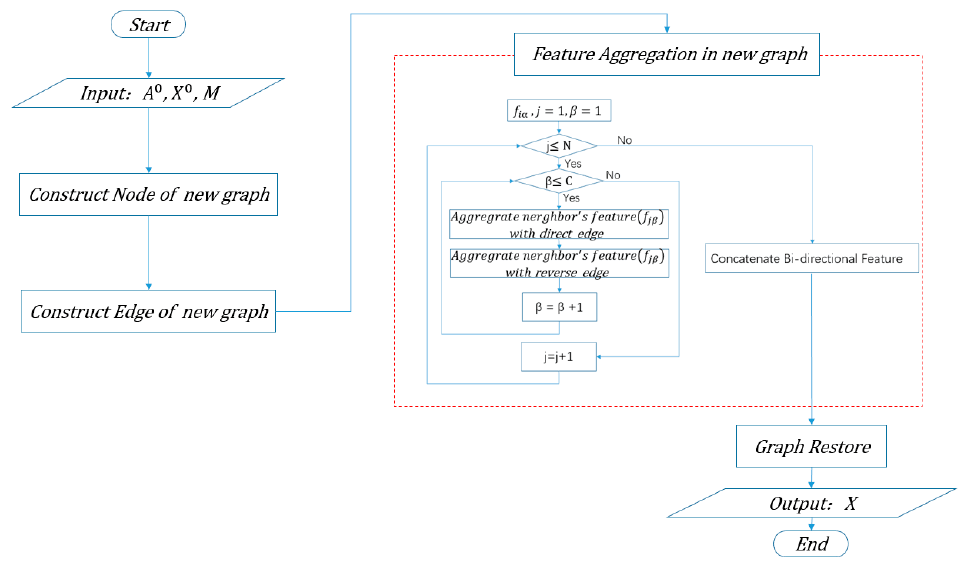
Figure 14. Flow chart of knowledge embedding. The inputs include a spatial adjacency matrix A 0 , node features X 0 , and co-occurrence matrix M . The output is updated node features X after knowledge embedding.